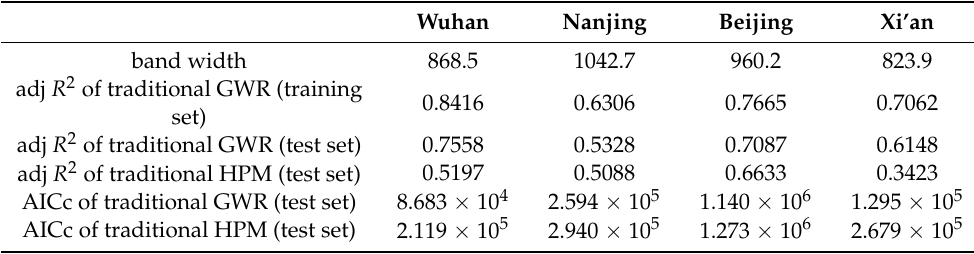
Table 4. The results of traditional GWR.